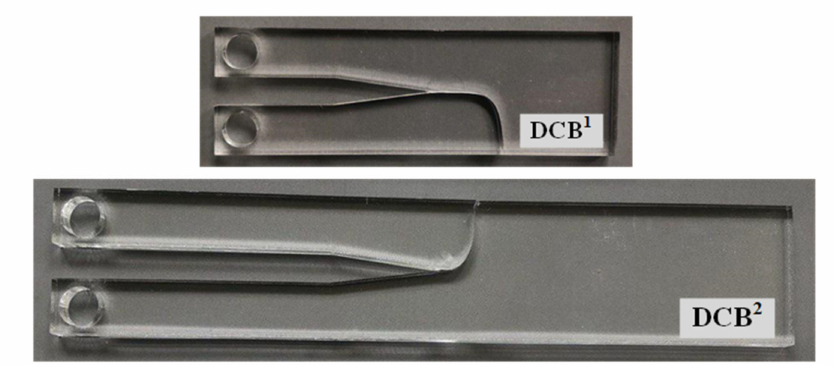
Figure 15. Broken blunt V-notched DCB 1 and DCB 2 specimens under mode I loading. γ = 15 ◦ ; ρ = 0.125